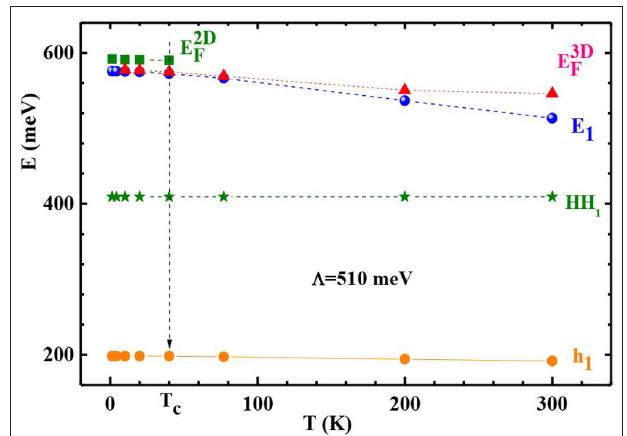
FIGURE 8 | Energy of the first conduction (E 1 ), valence (HH 1 and h 1 ) subbands, two and three dimensional Fermi level energy (E F ) at different temperatures.